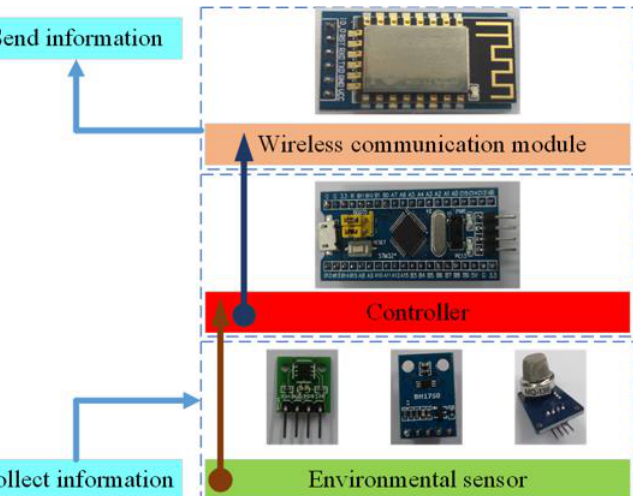
Figure 5. Flow chart of multi-threaded processing environment information data program.